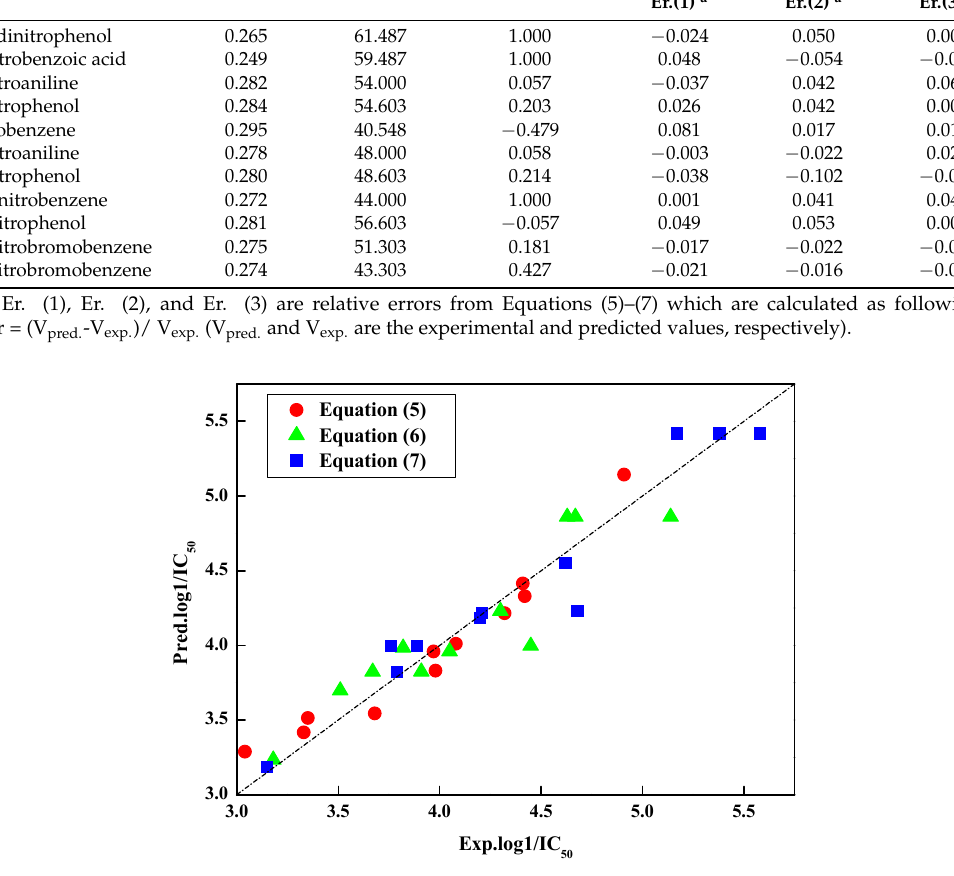
Figure 2. Plot of experimental and predicted values of nitro-substituted benzenes in mixtures from Equation (5), Equation (6), and Equation (7).